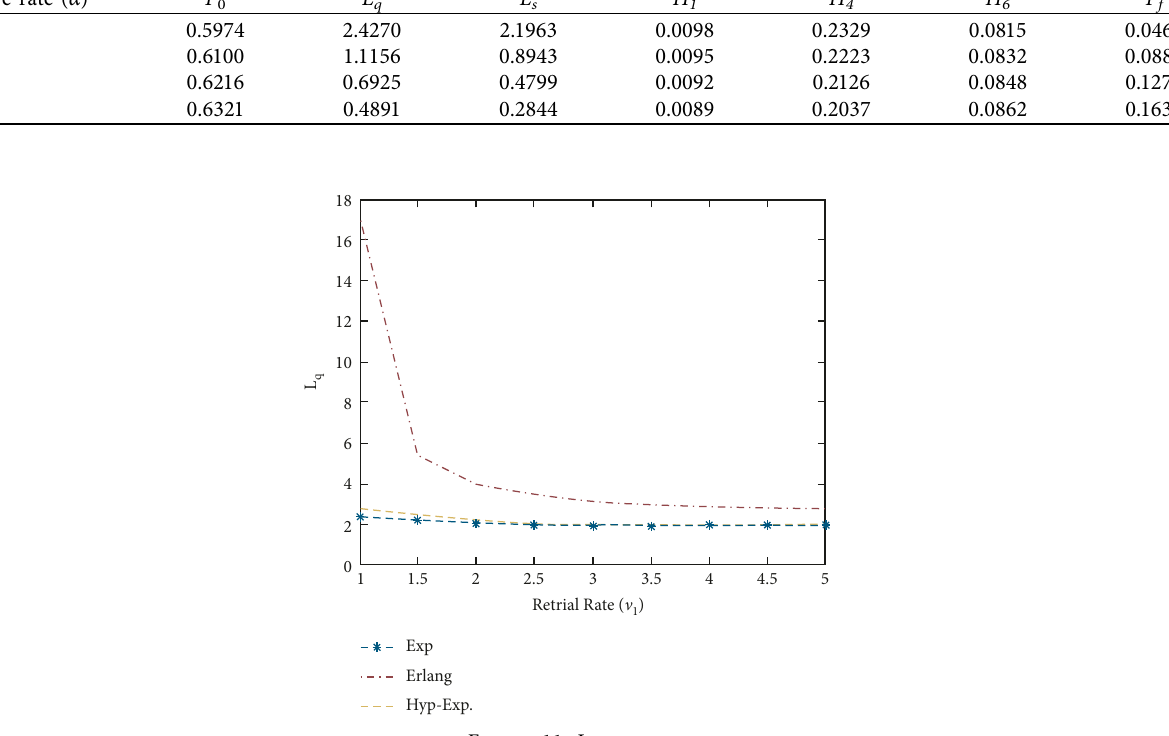
; ] , λ , ] , ] , θ 1 , α 0 . 4 , ] 7 4 . 1 (cid:31) 2 2 (cid:31) 1 4 (cid:31) 4 1 (cid:31) 3 6 (cid:31) 2 (cid:31) (cid:31) (cid:31)